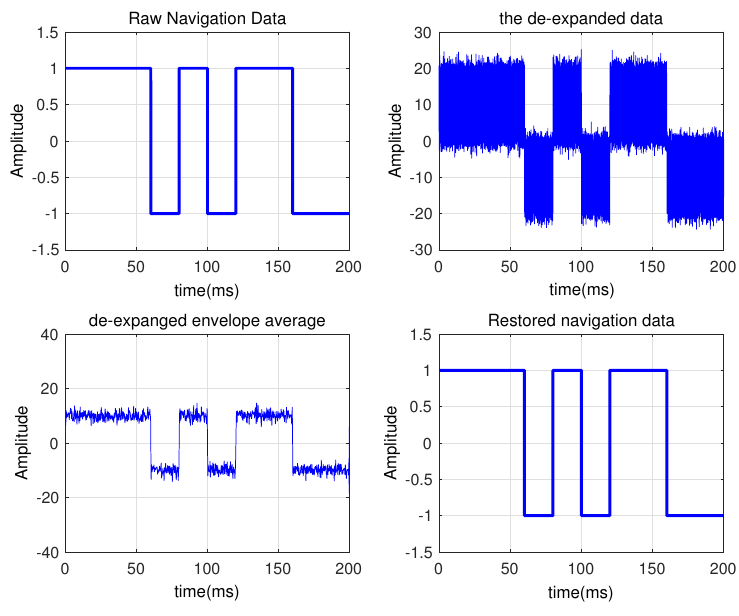
Figure 8. Reference signal demodulation